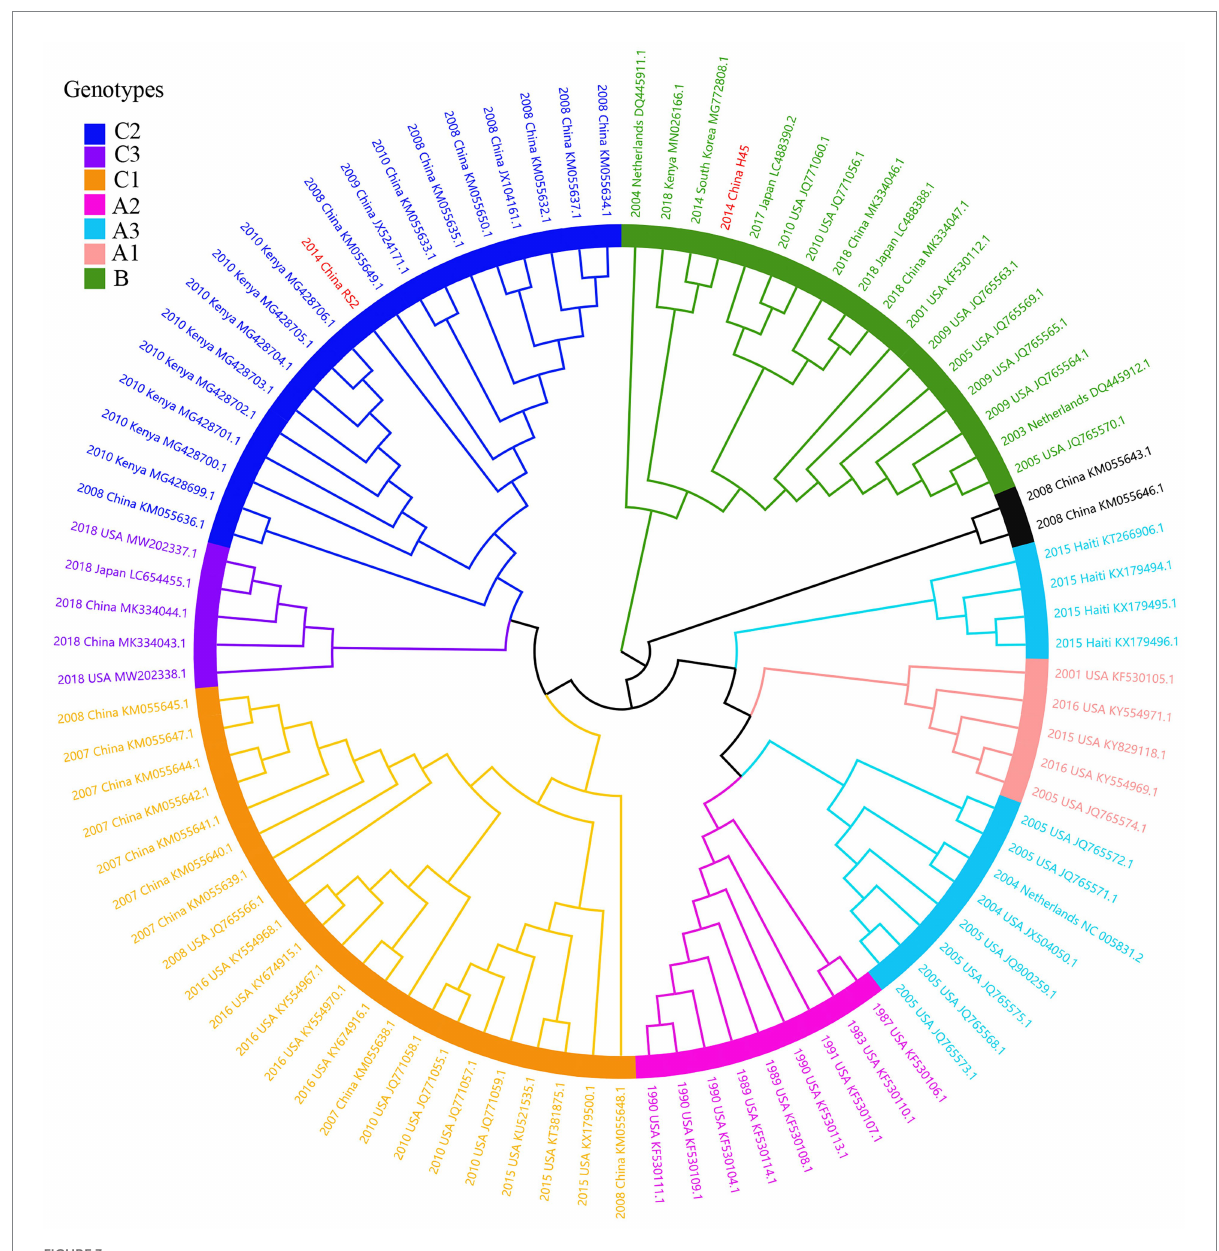
FIGURE 3 ML tree for the complete S gene of HCoV-NL63. Genotype classification is color-coded and sequences obtained in this study are colored red. The year of sampling, city and accession number are at the tip labels. Phylogenetic analysis using MEGA v6.0 with 1,000 bootstrap